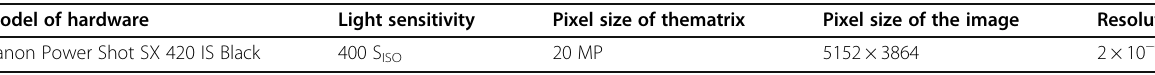
Table 2 Hardware parameters Model of